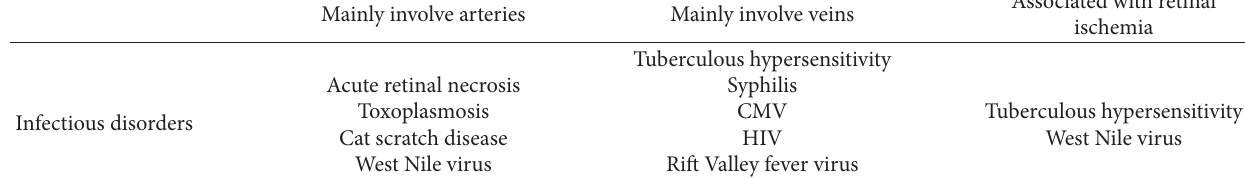
Table 1: Cause of retinal vasculitis according to the type of vessels involved and association with retinal ischemia. Mainly involve arteries